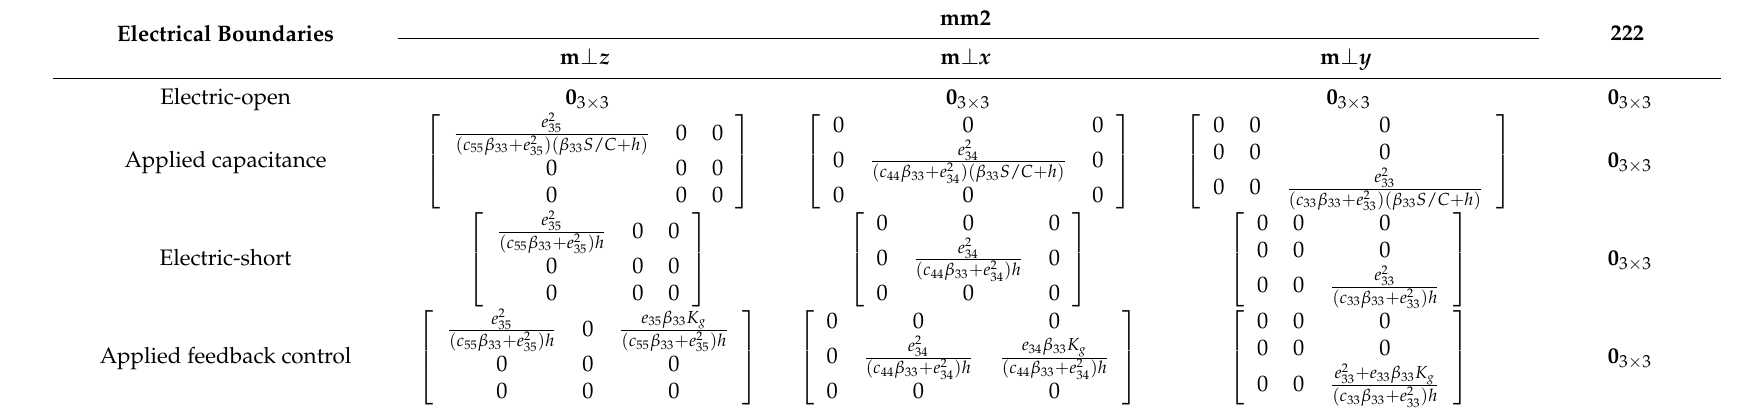
Table A1. The components of matrix G − 1 e T R for orthotropic layer of crystal classes mm2, and 222 with various electrical boundaries. p 3